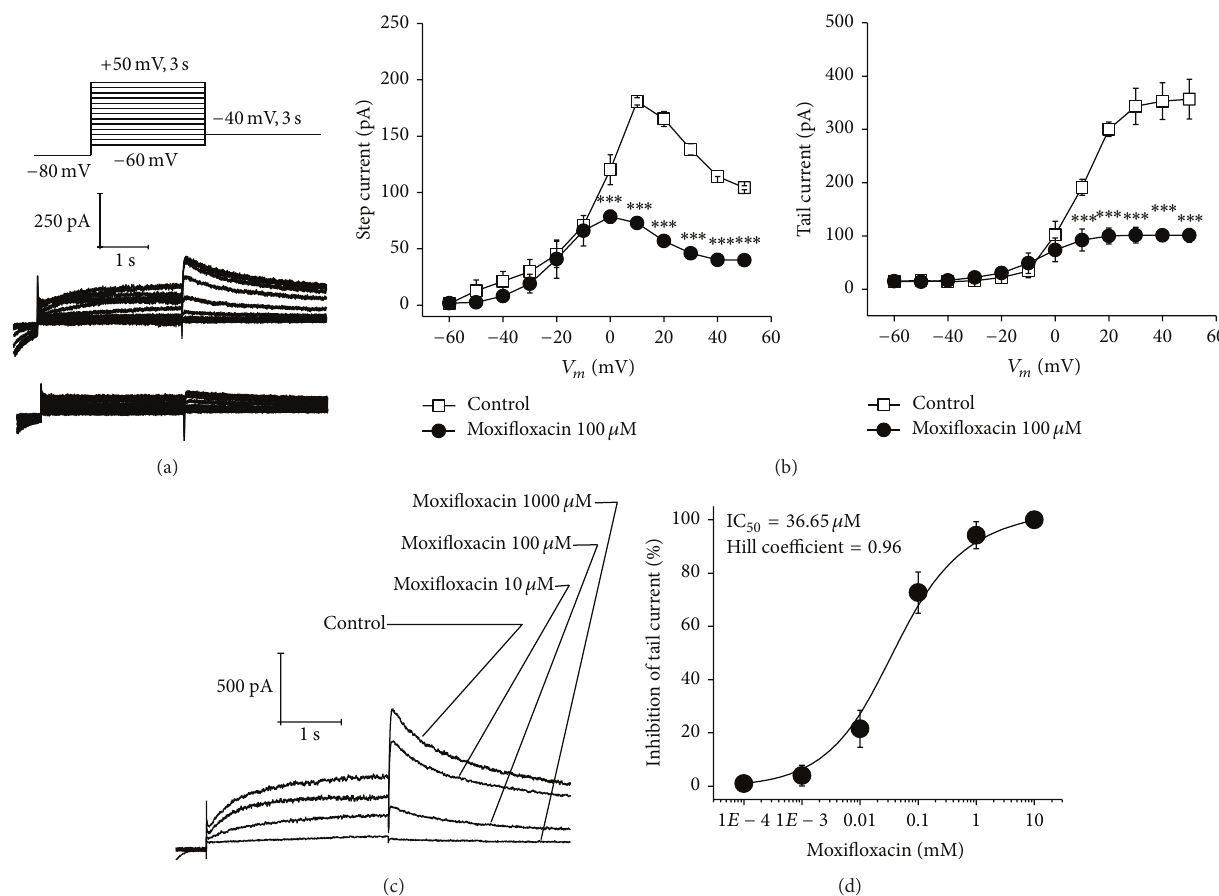
Figure 2: Moxifloxacin-induced inhibition of the HERG channel in HEK293 cells. (a) Cells were voltage-clamped at − 80 mV for 1 s, were depolarized from − 60mV to +50 mV for 3 s, and were repolarized to − 40mV for 3 s. HERG currents were recorded in transfected HEK293 cells with and without 100 𝜇 mol/L of moxifloxacin. (b) The time-dependent current and peak tail current I - V curves were recorded before and after cell perfusion with 100 𝜇 mol/L of moxifloxacin. (c) Cells were depolarized to a voltage of +20mV for 3s using a stepped procedure. Peak tail currents were recorded at different moxifloxacin concentrations (10, 100, and 1000 𝜇 mol/L). (d) A moxifloxacin concentration-response curve was fitted to a Hill equation, 𝑦 = [(𝐴 1 − 𝐴 2 )/(1 + (𝑥/𝐶)𝑛 𝐻 )] + 𝐴 2 , in which 𝐴 1 represents 0 tail current inhibition, 𝐴 2 represents 100% inhibition, 𝐶 represents the IC 50 concentration, and 𝑛 𝐻 represents the Hill slope. ∗∗∗ 𝑃 < 0.001 , 𝑛 = 4